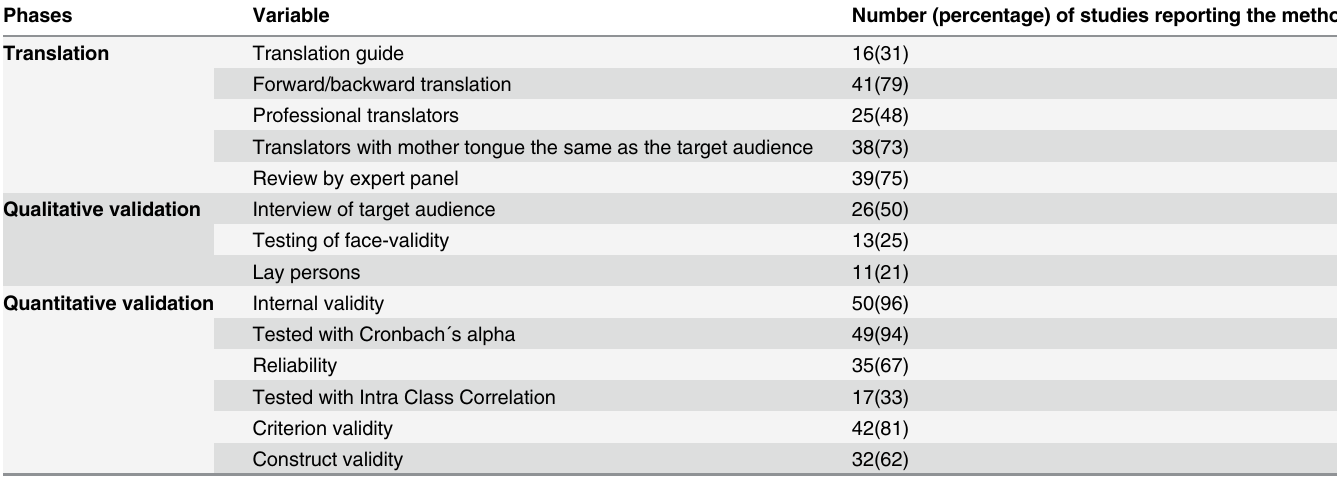
Table 2. Presenting numbers of variables (showing percentages in brackets) related to the phases of translation, the qualitative validation and the quantitative validation.